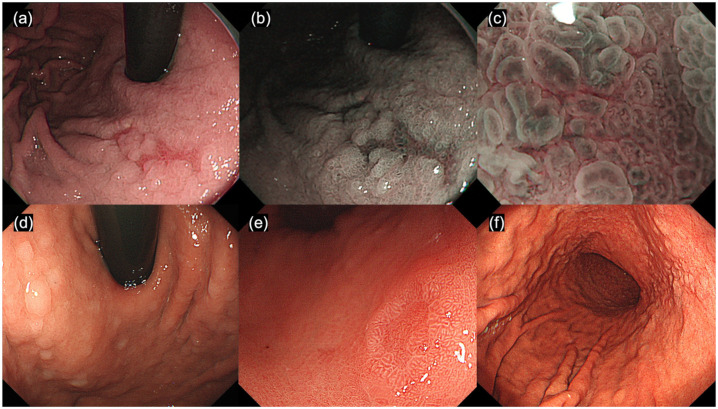
Representative endoscopic images.(a) White-light endoscopic view reveals a gastritis-like appearance (GLA). (b) Narrow-band imaging view with GLA. (c) Narrow-band imaging with magnifying endoscopic view with GLA. (d) White-light endoscopic view reveals multiple white elevated lesions (MWELs). (e) White-light endoscopic view reveals a reddish depressed lesion (RDL). (f) White light endoscopic view reveals a white nodular mucosa (WNM).